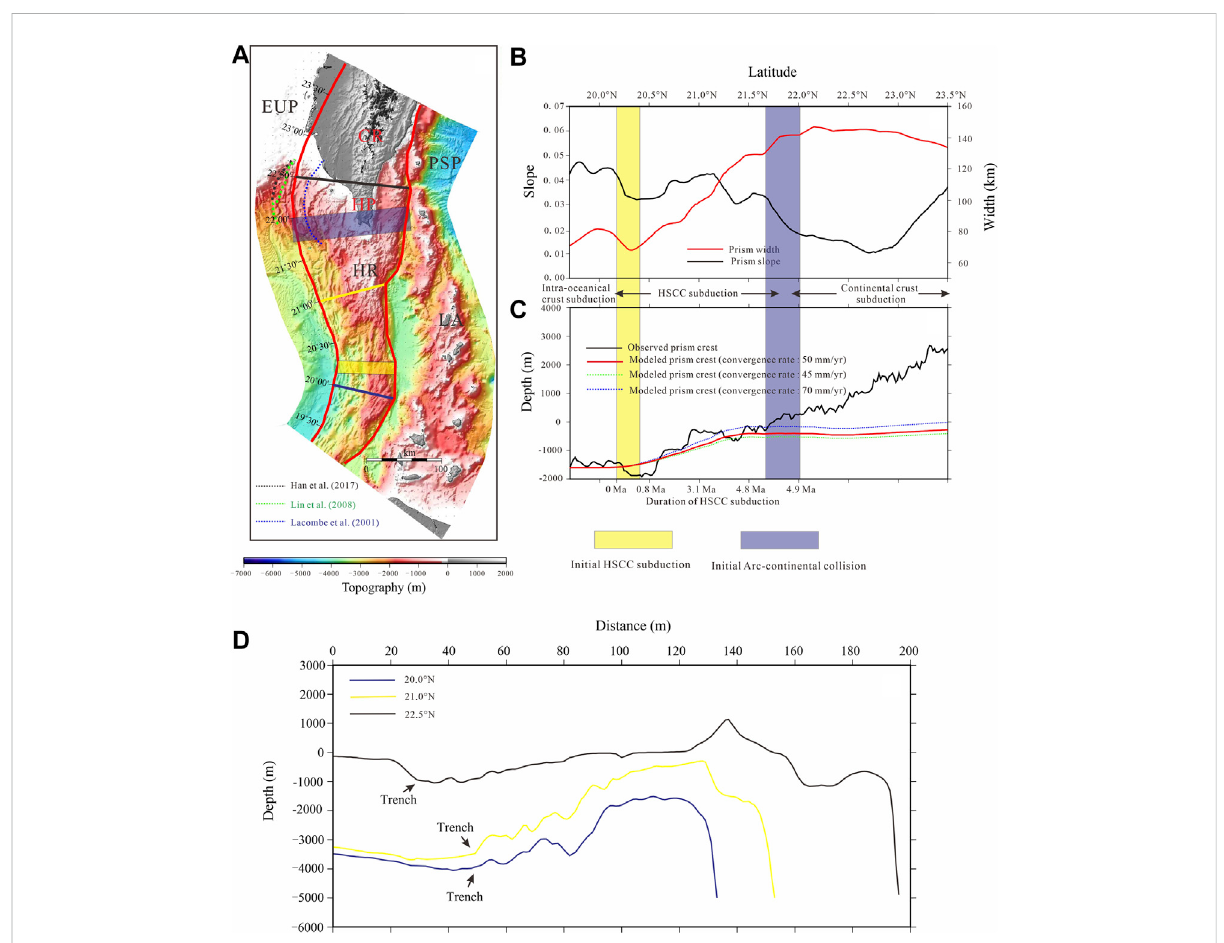
FIGURE 4 (A) Bathymetry of the Taiwan accretionary prism from 19.5 ° N to 24 ° N. Solid red lines indicate the western and eastern boundaries of the accretionaryprism.Black,green,andbluedottedlinesindicatepossibletrenchlocationsproposedbyHanetal.(2017),Linetal.(2008),andLacombe et al. (2001) SW of Taiwan Island. (B) Variations in prism width and slope from 19.7 ° N to 23.5 ° N. (C) Comparison between the modeled (red solid line) and observed prism crest (black solid line) from 19.7 ° N to 23.5 ° N. The modeled duration of the subducted hyperextended continental crust is shown below. The green and blue dash lines show the modeled prism crest using E-W effective convergence rate at 45 and 70 mm/yr, respectively. (D) Pro fi les across the accretionary prism at 20.0 ° N, 21.0 ° N, and 21.5 ° N, representing a typical cross section of oceanic subduction, hyper-stretched continental crust subduction, and initial arc – continental collision, respectively. CR: Central Ridge, EUP: Eurasian Plate, HR: Hengchun Ridge, HP: Hengchun Peninsula, LA: Luzon Arc, PSP: Philippine Sea